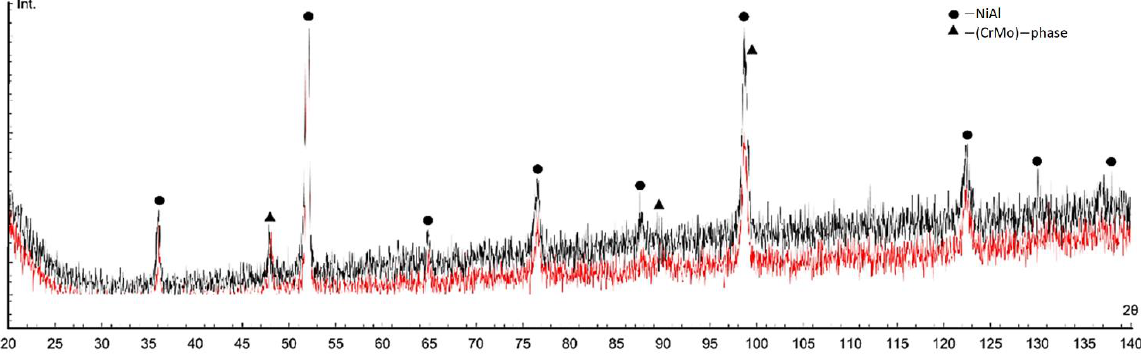
Figure 6. X-ray diffraction patterns of sintered matrix samples with 0.01 wt.% MgAl 2 O 4 (black) or 0.01 wt.% ZrO 2 (red) nanoparticles additions (Int. — intensity in arbitrary units).